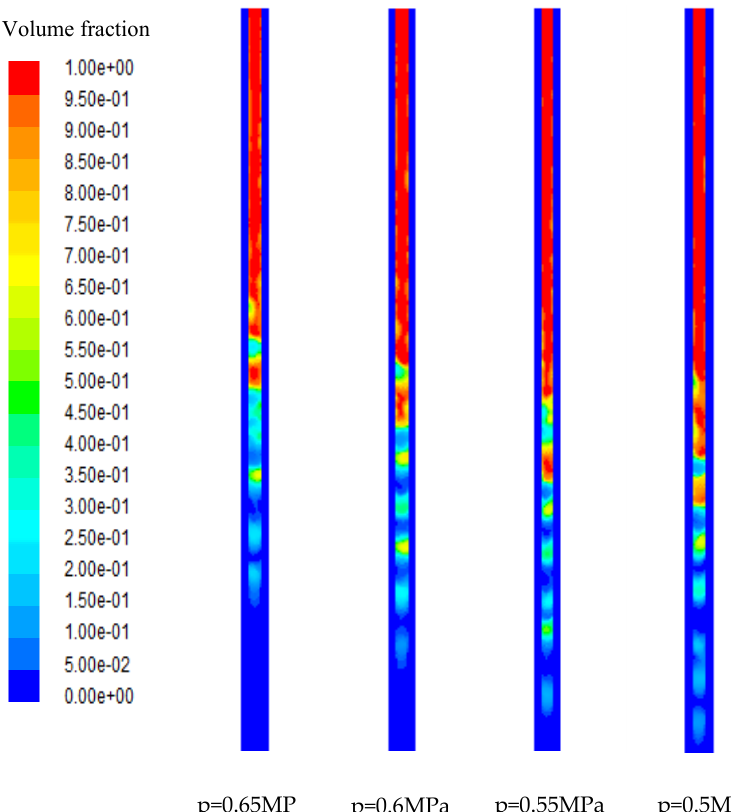
Figure 16. Flow patterns for different pressures and G = 10.52 kg m - 2 s - 1 .